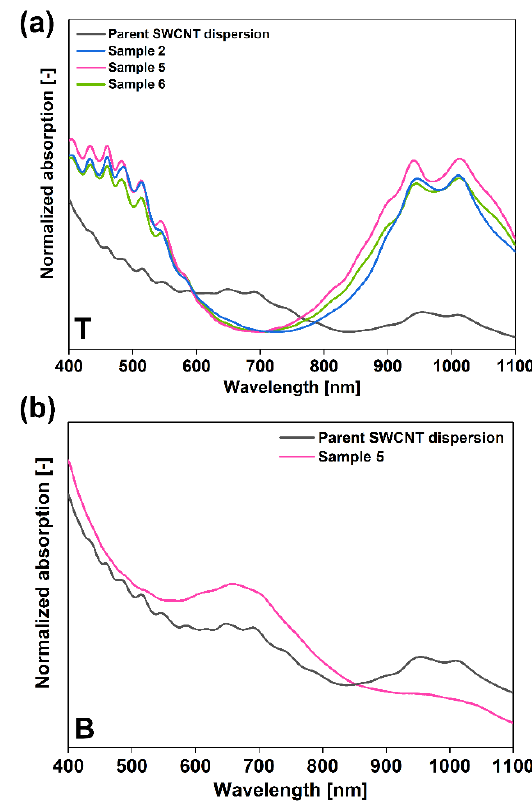
Figure 4. Absorption spectra of ( a ) top phases (PEG) of Samples 2, 5 and 6 and ( b ) bottom phase (DEX) of Sample 5 collected after ATPE separation at a selected concentration of H 2 O 2 with varying contents of the introduced SWCNT dispersion. In both cases, the optical absorption spectrum of the parent dispersion is provided as a reference.